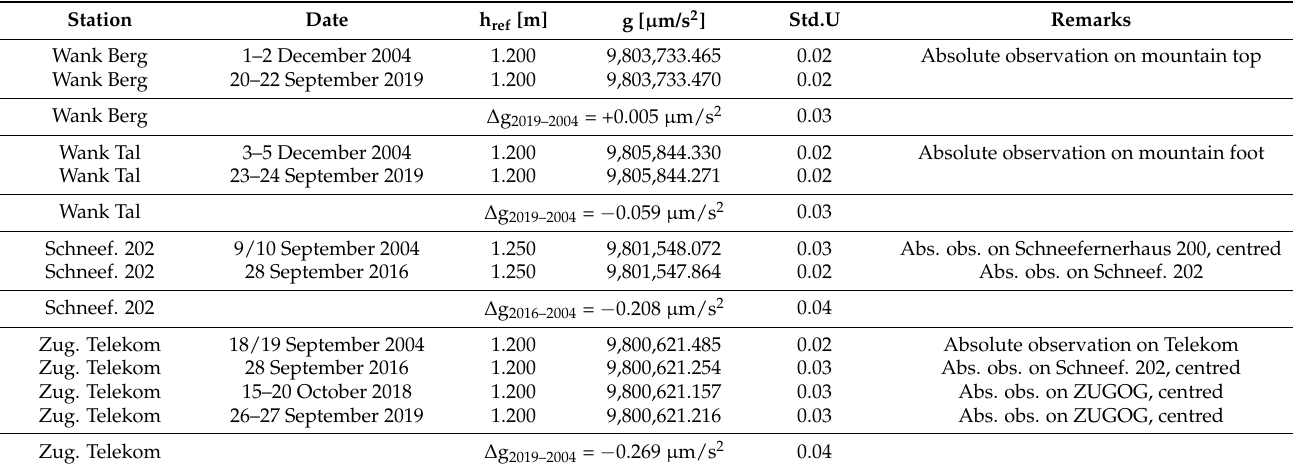
Table 4. Absolute gravity values (at reference height h ref = 1.200 m or 1.250 m above floor mark) of the FG5-220 stations at Mt. Wank and Mt. Zugspitze as determined in the period 2004 to 2019. Scheme 5. which is derived as an empirical estimate. Because of the assumptions in the uncertainty estimates, they are given here as rounded values. In case of transferring an absolute observed g-value to another point by relative gravimetry (centred), the uncertainty has been increased from 0.02 µ m/s 2 to 0.03 µ m/s 2